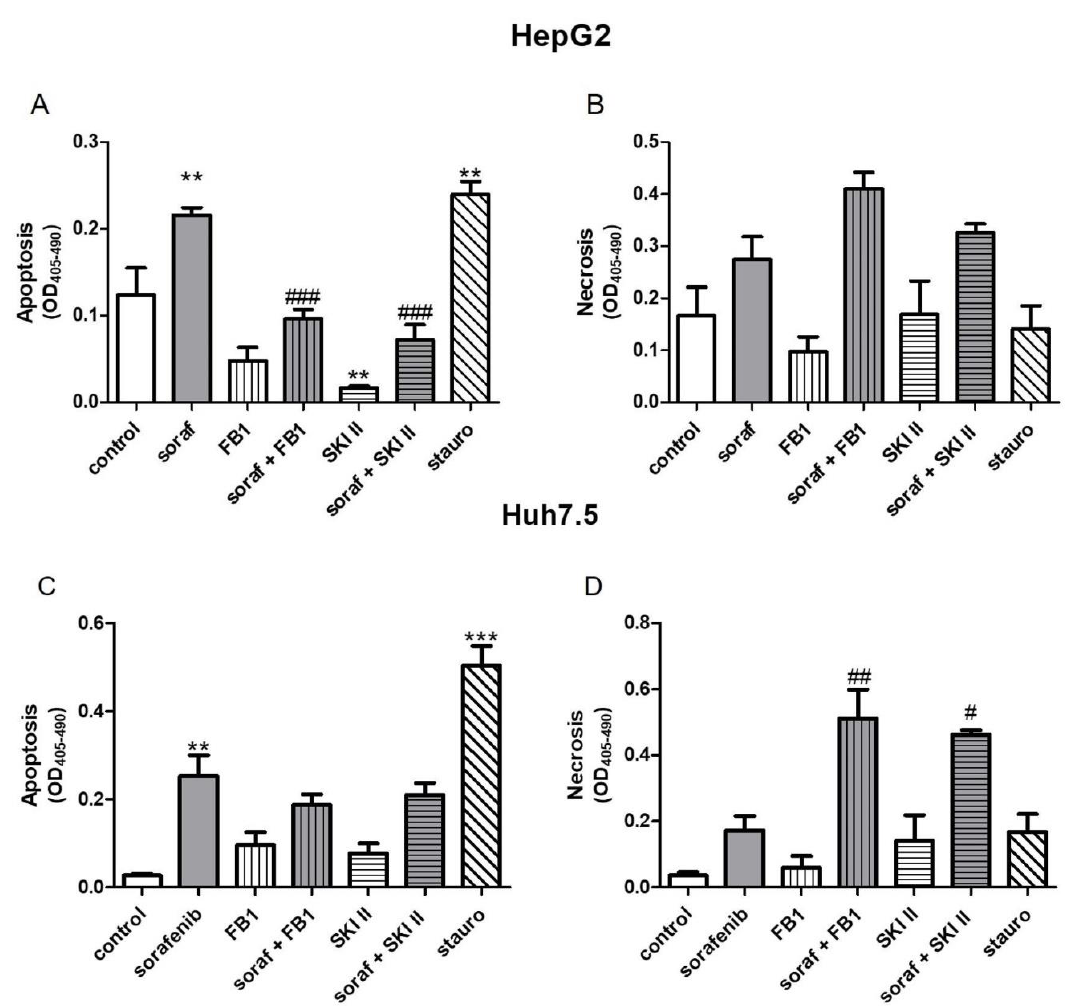
Figure 3. Influence of sorafenib, FB1, and S KI II on the apoptosis and necrosis of HepG2 and Huh7.5 cells. Apoptosis and necrosis were analyzed by measuring DNA fragmentation of the cytoplasmic fraction or in the supernatant. The cells (HepG2 in ( A ) and ( B ) and Huh 7.5 in ( C ) and ( D )) were pretreated with 25 µ M FB1 for 1 h, or with 10 µ M SKI II for 2 h. Then, vehicle (control; 0.2% DMSO) or 5 µ M sorafenib (soraf) were added for the indicated periods of time. Staurosporine (stauro) was used as a positive control. All data are derived from three independent experiments performed in triplicate. The values are means ± SEM and expressed relative to vehicle control at 24 h. ** p < 0.01, *** p < 0.001 compared to control; # p < 0.05, ## p < 0.01, ### p < 0.001 compared to sorafenib in a one-way analysis of variance with subsequent Bonferroni test. ( n = 3 for all conditions).